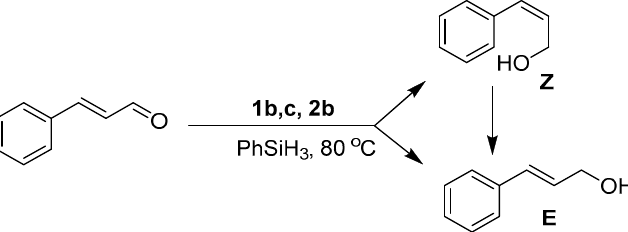
Figure 4. Formation of E and Z isomers of cinnamyl alcohol after 10 min of reaction followed by full conversion to the E isomer at reaction